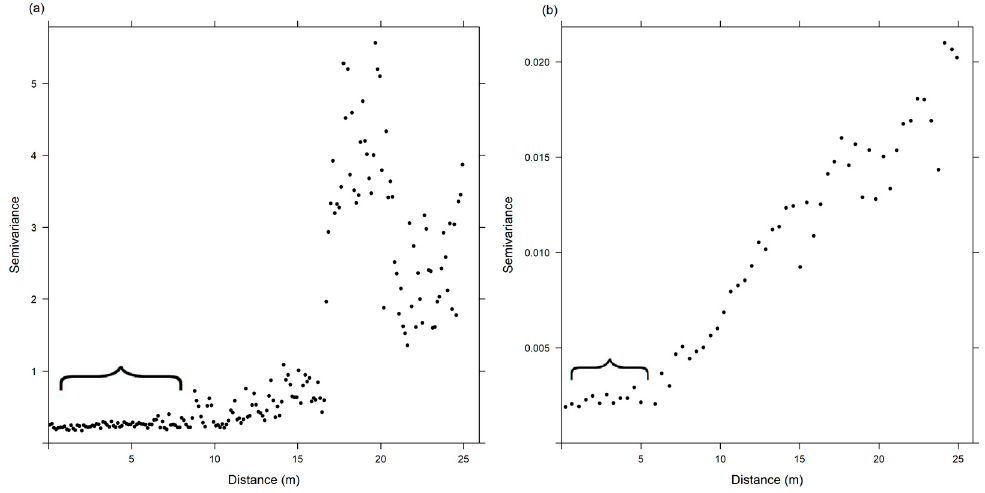
Figure 9. Sample variograms of flight A5 on June 29 ( a ) and B6 on June 30 ( b ).